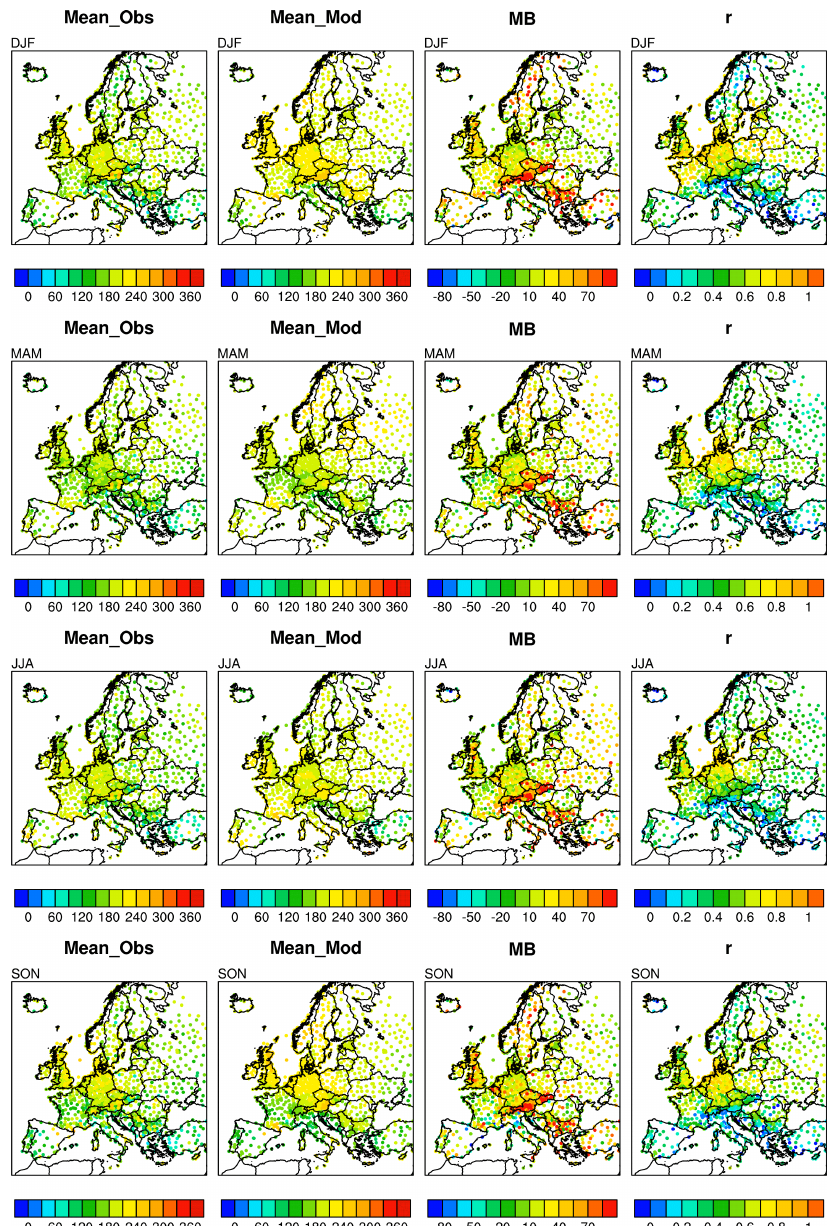
Figure 3. Seasonal average values of 10m wind direction (WD10) in degrees. Model results and statistics are shown for the MOZART simulation at the locations of the